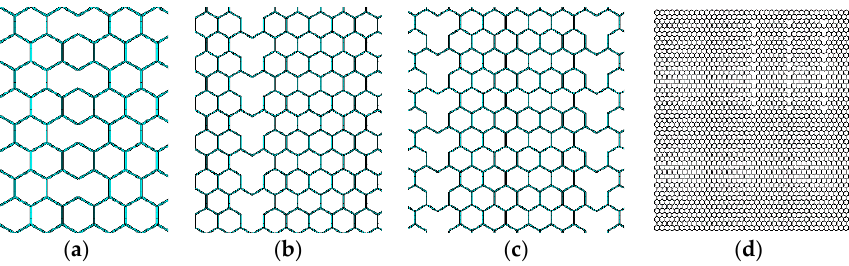
Figure 9. Periodic dispersion vacancy defects. ( a – d) for first-fourth mode of periodic vacancy defects.